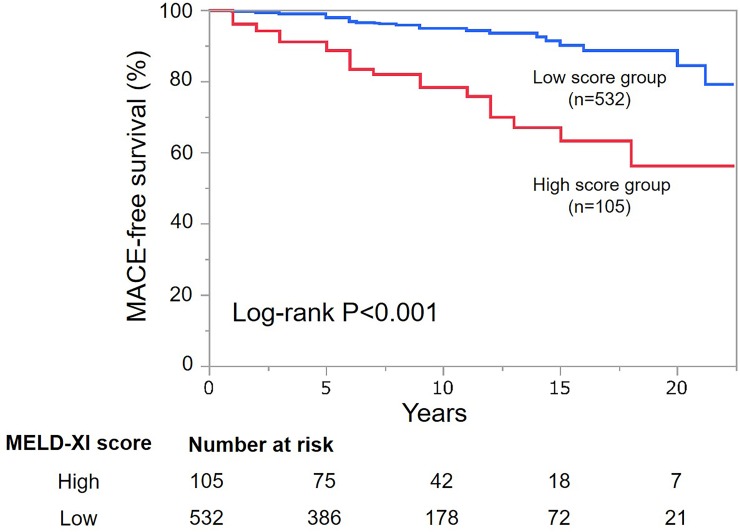
Kaplan-Meier curves according to the MELD-XI score.The high score group had significantly poor MACE-free survival compared with the low score group (log-rank, P<0.001). MACE, major adverse cardiac events; MELD-XI, model for end-stage liver disease excluding international normalized ratio.